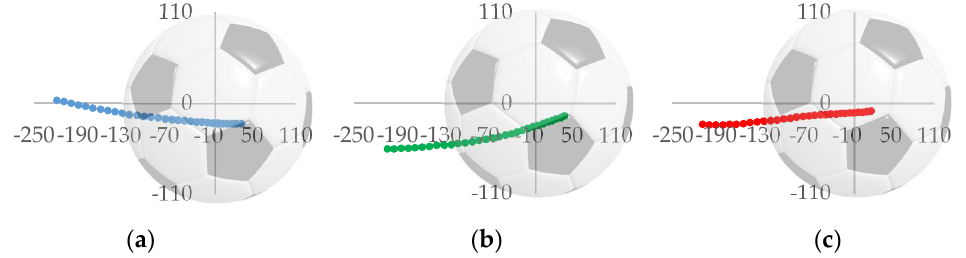
Figure 7. Side view of the POF trajectory of three trial straight, curve and knuckle. ( a ) POF trajectory of straight went down under the center of ball; ( b ) POF trajectory of curve went up under the center of ball; ( c ) POF trajectory of knuckle went the nearest the center of